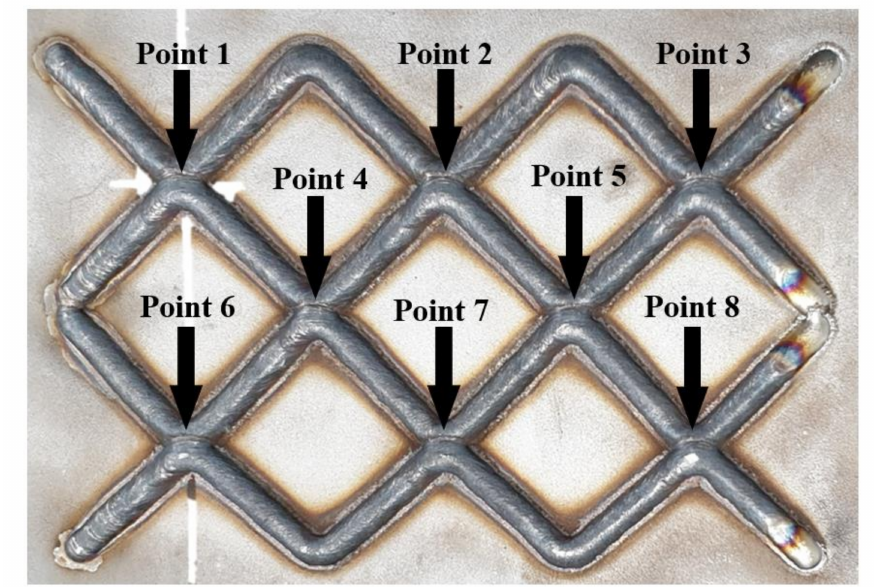
Figure 7. The result of single-layer